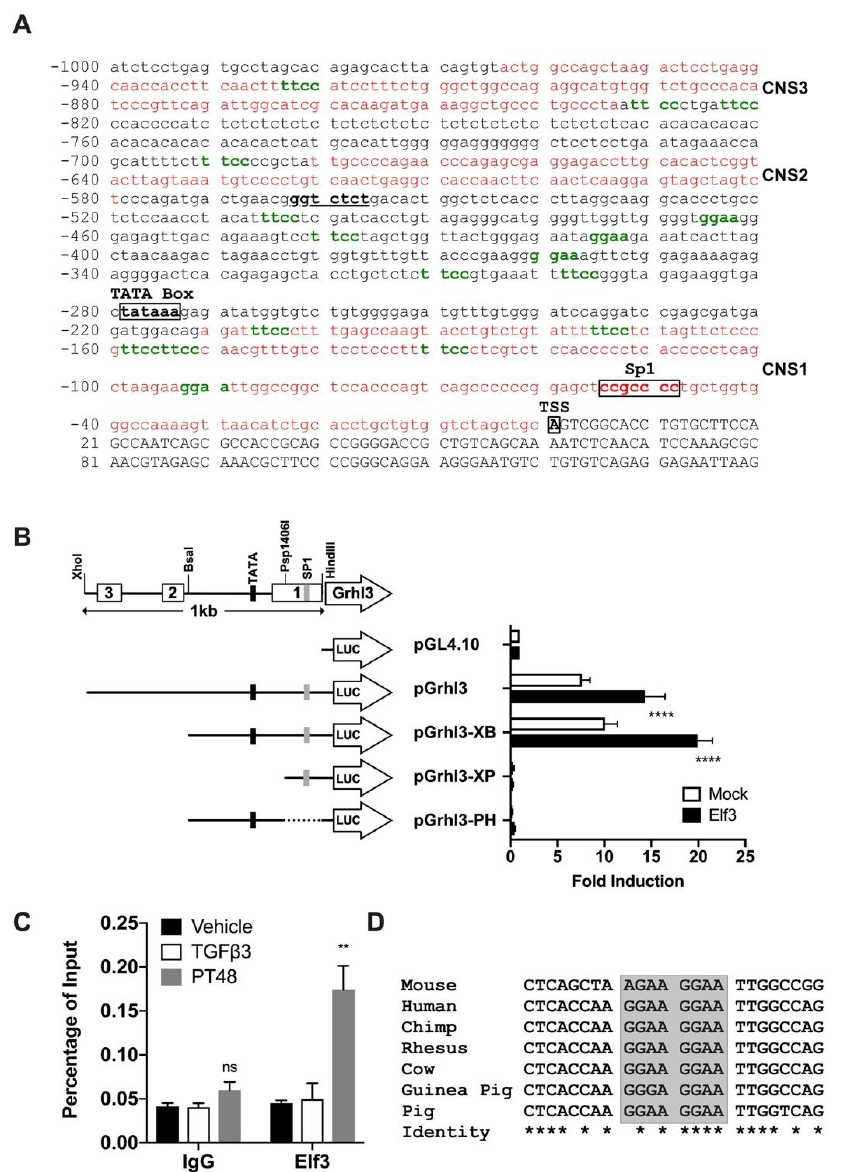
Figure 5. The transcription factor ELF3 regulates the Grhl3 promoter. ( A ) The sequence of the Grhl3 promoter (1000 bp) showing the location of the predicted TATA box, SP1 sequence, and the transcription start site. Sequences in red represent the conserved regions, and green bases represent putative ELF3 binding sites. ( B ) Luciferase reporter assay showing the activation of the Grhl3 promoter by ELF3. Relative luciferase activity is calculated as fold induction relative to vector. Drawings on the left side show a schematic representation of the Grhl3 promoter region (top) and the structure of each reporter plasmid (below). The conserved regions are shown as horizontal boxes labeled 1,2 and 3, the restriction enzymes used to generate the reporter deletions of the promoter are labeled. ( C ) ELF3 binding at the promoter of Grhl3 . NMuMG cells were treated with either vehicle or TGF β 3 for 72 h, TGF β 3 treated cells were then washed with PBS and continued incubation for an additional 48 h to initiate MET (post-treatment: PT48). Cells were cross-linked, and chromatin immunoprecipitation was performed. ChIP DNA was used in qPCR to measure the occupancy of ELF3 compared to control antibodies. ( D ) Sequence alignment of one putative ELF3 binding site in the Grhl3 promoter showing conservation among different species. In B and C, data represent the averages of at least three independent experiments. The paired Student’s t -test was used to calculate statistical significance. ** p -value < 0.01; **** p -value < 0.0001.